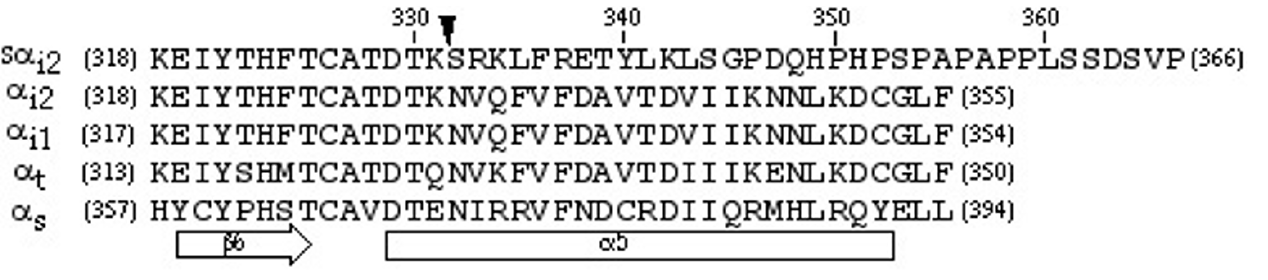
Figure 1 C-termini of G protein α subunits An alignment of C-terminal amino acids of selected G α is shown. The arrow indicates the site at which a novel 35 amino acids in s α i2 replaces the C-terminal 24 amino acids of α i2 . Amino acid numbering is indi- cated in parentheses. Secondary structure is indicated at the bottom